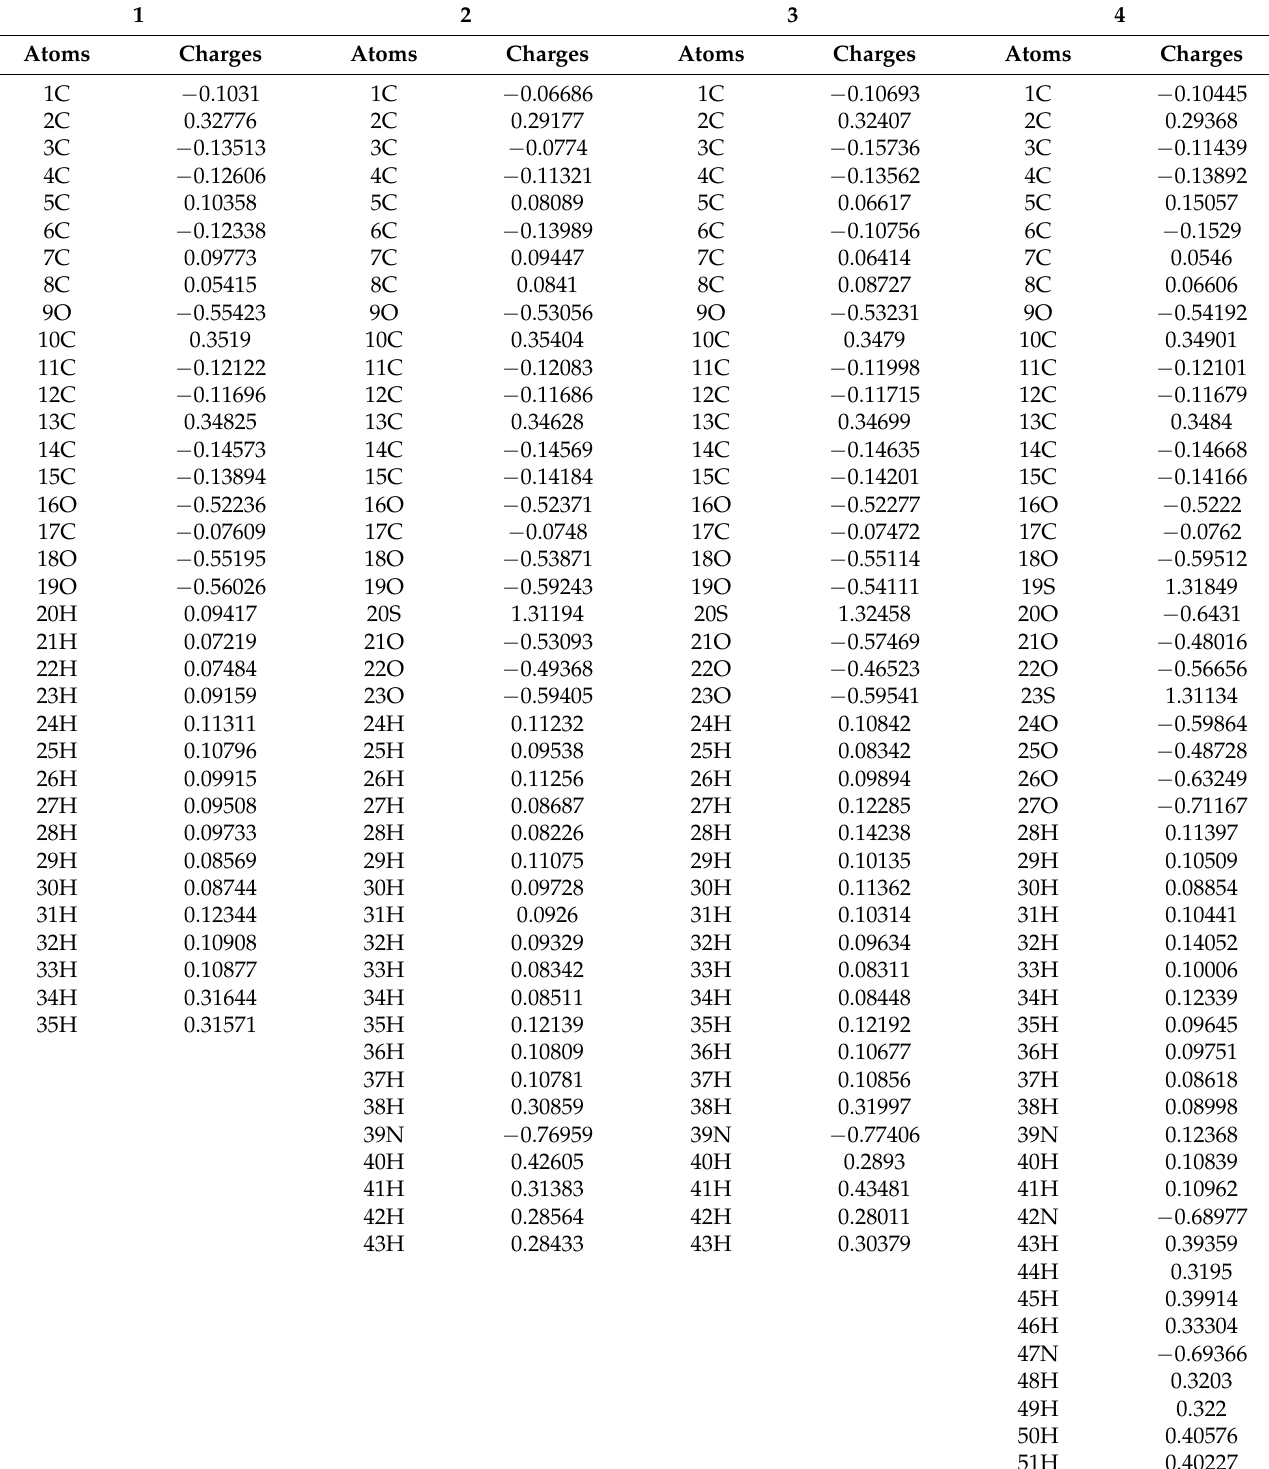
Table 4. Mulliken atomic charges for the investigated